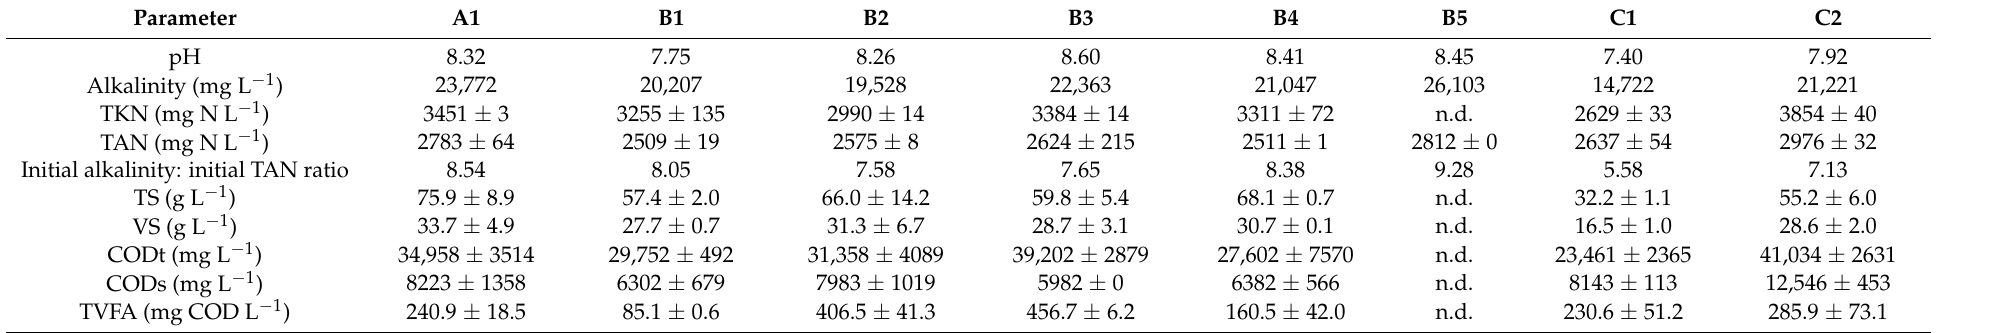
Table 1. Characteristics for the digestate in the different batch